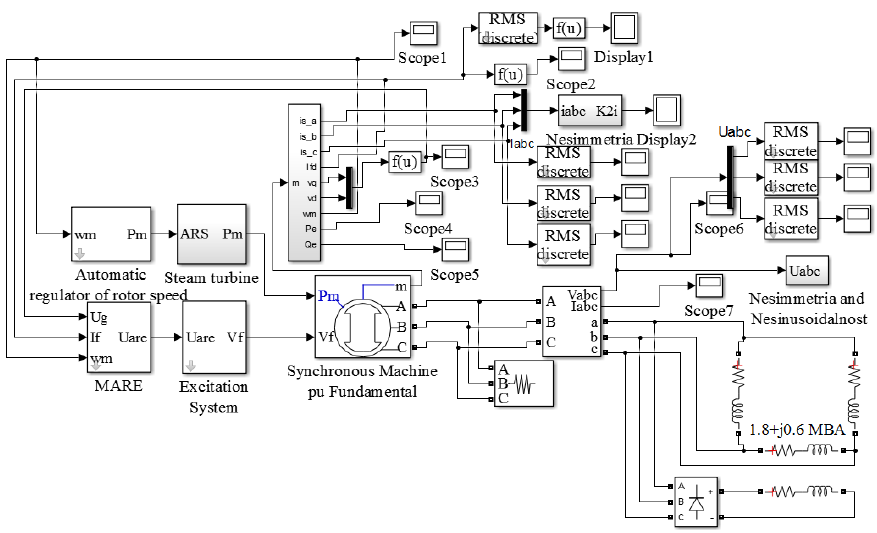
Figure 8. Flow chart of the model of the turbogenerator serving balanced and non-linear loads in